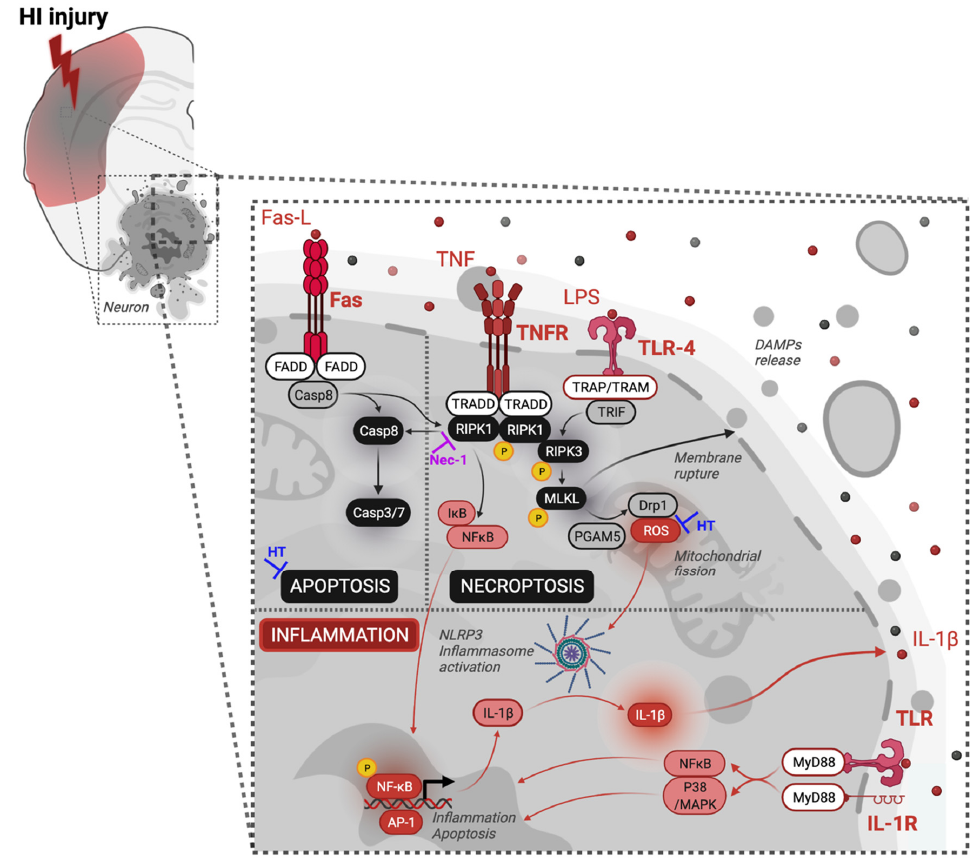
Figure 5. Schematic hypothesis of the continuum necroptosis/apoptosis/inflammation of neuronal cell death in HIE. Necroptosis is triggered by inflammatory mediators, including Fas-L and TNF- α . Upon the recruitment of adapter proteins by the ligands mentioned above, it will induce the phos- phorylation of RIPK1. RIPK1 is a pivotal kinase that could induce (i) inflammation via the activation of NF κ B [34], (ii) apoptosis when caspase-8 is activated, or (iii) necrosome formation if caspase-8 is inhibited. The necrosome is composed of interaction and activation of RIPK1 and RIPK3, followed by the recruitment and phosphorylation of MLKL. The necrosome will then induce necroptosis of the cell through upregulation of ROS and/or mitochondrial fission through interaction with mitochondrial phosphatase PGAM5 and Drp1 activation. Phosphorylated MLKL can also initiate cell death by disrupting the plasma membrane integrity [21,30,66–71]. Abbreviations: Drp1: dynamin-related protein 1; FADD: Fas-Associated protein with Death Domain; Fas-L: Fas-ligand; MLKL: mixed- lineage kinases domain-like; Nec-1: necrostatin-1; NF κ B: nuclear factor κ B; p: phosphorylated; PGAM5: phosphoglycerate mutase family member 5; RIPK: receptor-interacting protein kinases; ROS: reactive oxygen species; TNF- α : tumour necrosis factor α ; TNFR1: tumour necrosis factor receptor 1; TRADD: Tumour necrosis factor receptor type 1-associated DEATH. Created with BioRen- der.com (access on 10 May